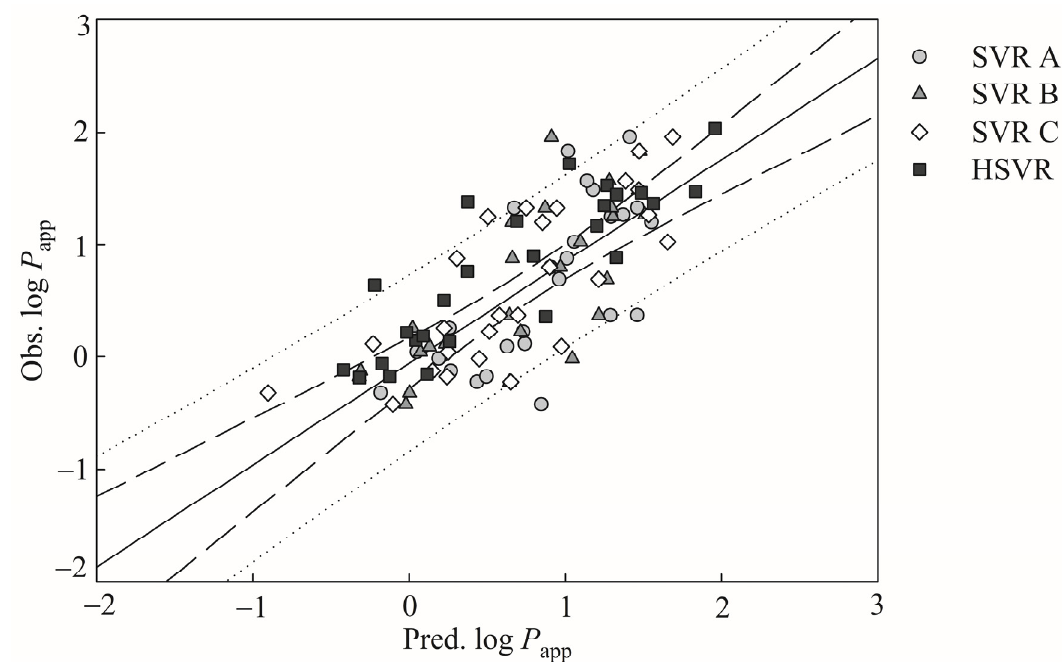
Figure 3. Observed log P app versus the log P app predicted by SVR A (gray circle), SVR B (gray triangle), SVR C (open diamond), and HSVR (solid square) for the test samples. The solid, dashed, and dotted lines represent the HSVR regression of the data, 95% confidence intervals for the HSVR regression, and 95% confidence intervals for the prediction, respectively.